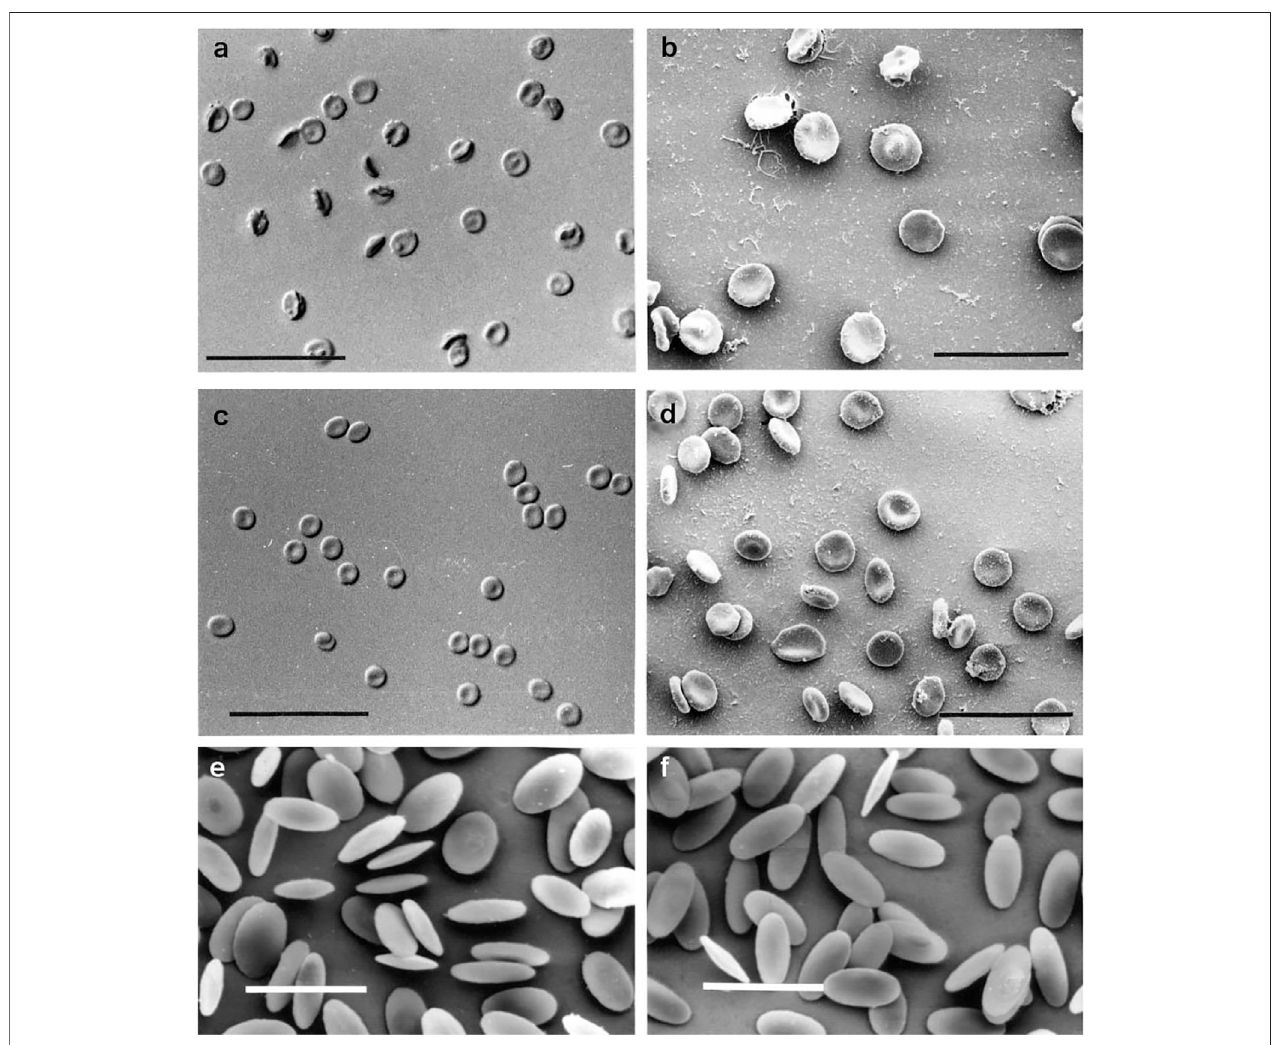
FIGURE 3 | (A) DIC optical micrograph of Indian elephant ( Elephas maximus ) RBCs. Scale bar = 50 µm (Nikon Eclipse E800 Plan Apo ×40 0.95NA objective); (B) Secondaryelectron SEMimage ofIndian elephantRBCs.Scalebar =22 µm (JeolJSM-6300f); (C) DICoptical micrograph ofhuman ( Homosapiens )RBCs.Scalebar = 50 µm (Nikon Eclipse E800 Plan Apo ×40 0.95NA objective.); (D) Secondary electron SEM image of human RBCs. Scale bar = 22 µm (Jeol JSM-6300f); (E) Secondary electron SEM image of washed RBCs from camel ( Camelus dromedarius ). Scale bar = 10 µm (JEOL JSM-6300f); (F) Secondary electron SEM image of washed RBCs from alpaca ( Lama pacos ). Scale bar = 10 µm (JEOL JSM-6300f). The original images were published by Benga et al., 1999; Benga et al.,